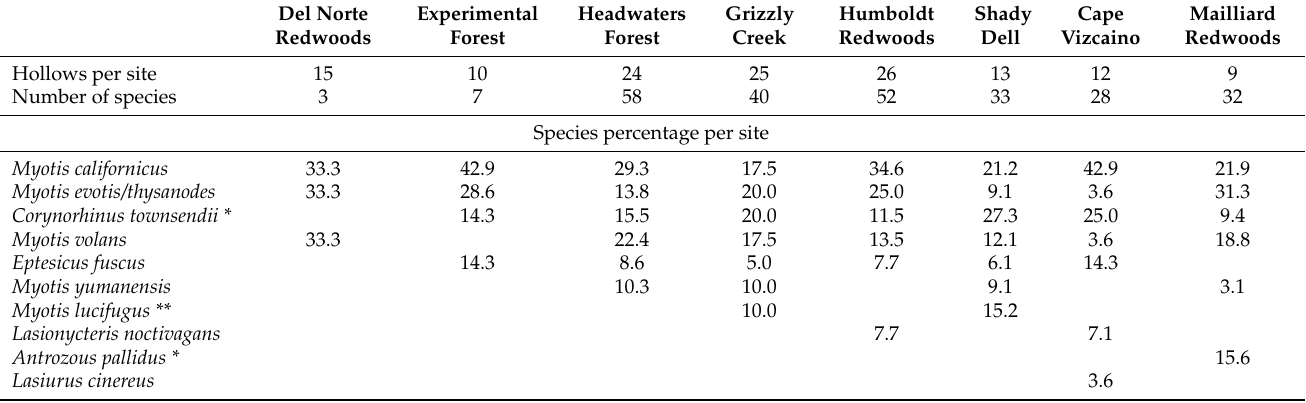
Table 2. Bat prevalence (species frequency) by percentage per site, based on species identifications from DNA analysis of pooled guano collections from 83 hollows over the study period (April 2017– September 2018), at eight sites on the North Coast of California. Asterisks indicate: * Species of Conservation Concern in the state of California; ** Species listed as Endangered by the IUCN. Del Norte Experimental Headwaters Grizzly Humboldt Shady Cape Mailliard Redwoods Forest Forest Creek Redwoods Dell Vizcaino Redwoods Species percentage per site